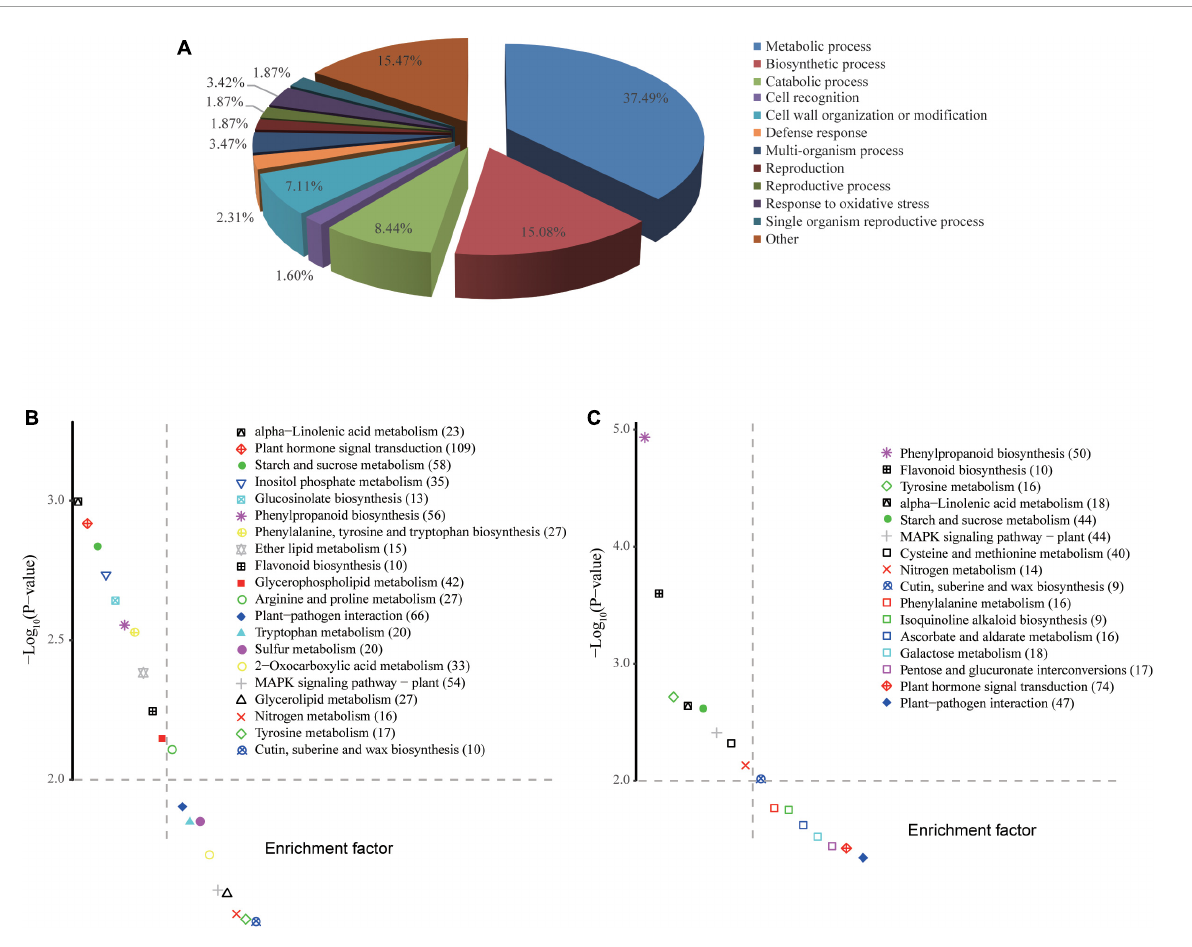
FIGURE5 GO enrichment and KEGG pathway analyses of DEGs. (A) Biological classification of all DEGs by GO enrichment analysis. (B,C) KEGG pathways enriched in ZS9m Xcc R-1 and ZS9m Xcc S-1, respectively. The vertical and horizontal axes of KEGG scatter diagrams represent the –log 10 ( P -value) and enrichment factor, respectively. Values in brackets are indicative of the number of DEGs enriched in each pathway.